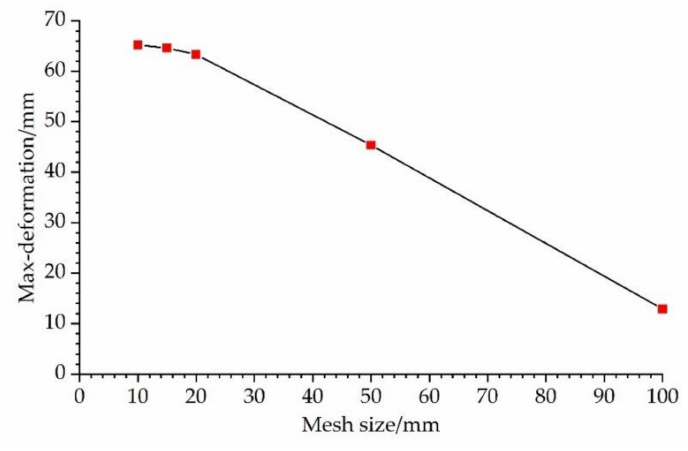
Figure 6. Maximum deformation of the sandwich panel with different mesh sizes.